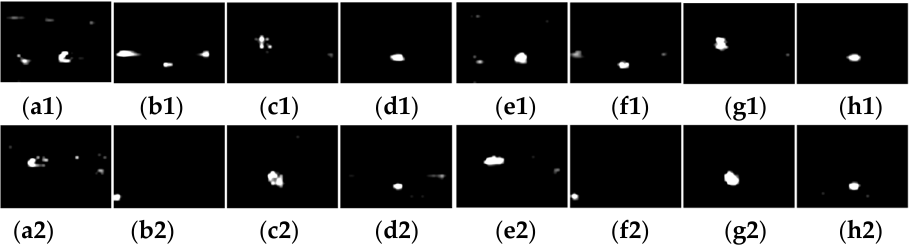
Figure 18. ( a1 – h1 ): operation results of “center-surround difference” applied in ITTI model. ( a2 – h2 ): the results of the “center-surround difference” operation of different scales in our model.